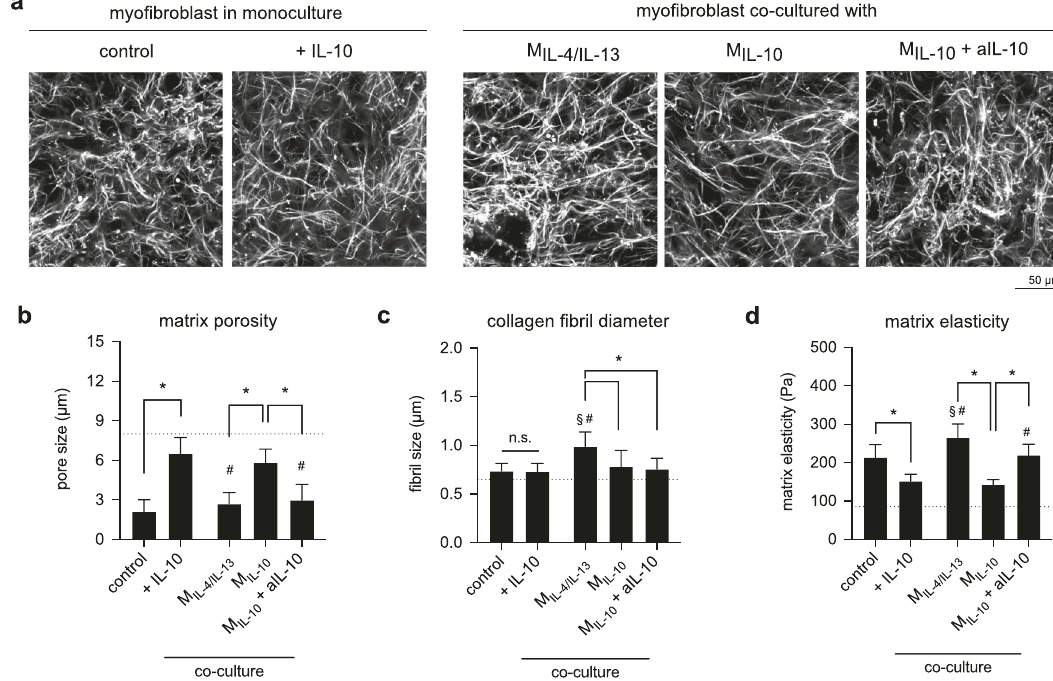
Fig. 7 Matrix remodeling by myo fi broblasts in the presence of IL-10 and co-culture with M2 subtypes. a Representative images of decellularized collagen matrices in mono and co-culture with M2 subtypes (scale bar: 50 μ m). Decellularized collagen matrices were characterized regarding b matrix porosity characterized as mean pore size, c collagen fi bril diameter, and d matrix elastic modulus. (Data are represented as mean ± SD; *signi fi cance level of p ≤ 0.05 using a one-way ANOVA followed by Tukey ’ s post hoc analysis.) The characters # and § represent the signi fi cance level of p ≤ 0.05 using a one-way ANOVA followed by Tukey ’ s post hoc analysis when compared to control, and treated samples with IL-10, respectively. For the quanti fi cation of matrix porosity and collagen fi bril diameter, 10 different positions of each matrix condition were analyzed. Experiments were performed in four